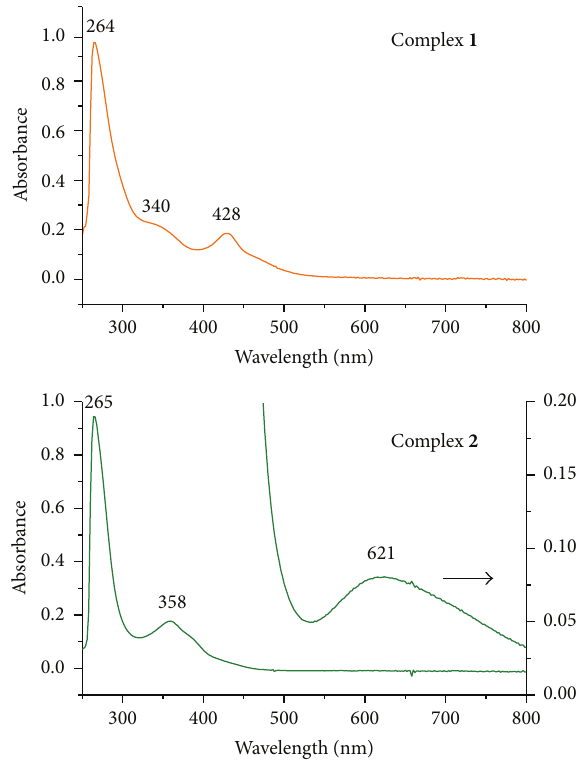
Figure 4: Electronic spectrum of complexes 1 and 2 in dimethylsul- foxide.